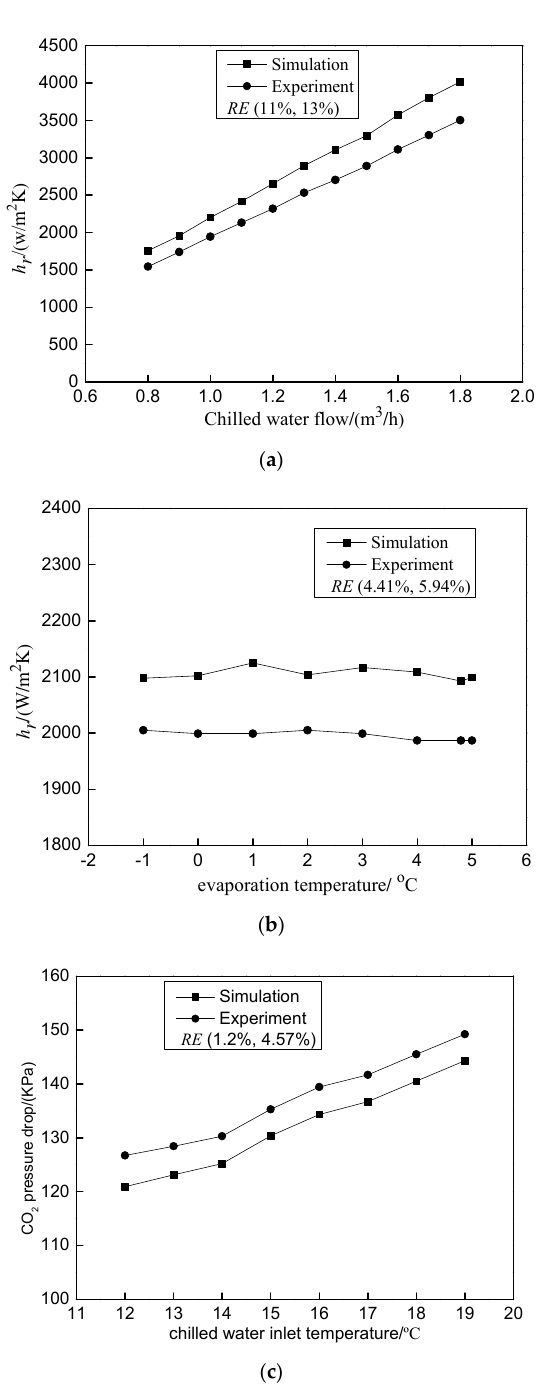
Figure 10. Comparison of experimental and calculated results. ( a ) E ff ect of chilled water flow on h r ; ( b ) E ff ect of evaporation temperature on h r ; and, ( c ) E ff ect of chilled water inlet temperature on CO 2 pressure